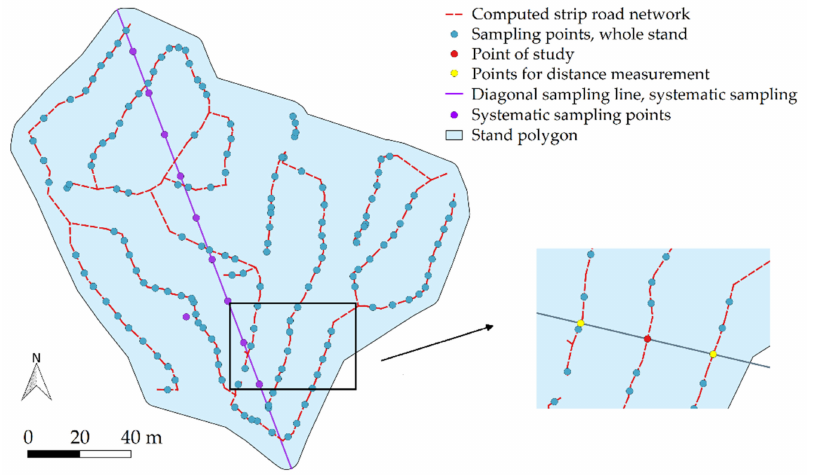
Figure 6. Example of sampling the stand for the calculation of strip road spacing. The sampling locations of the whole strip road network are shown with turquoise dots. In this sampling, the center point of the line segment under study is calculated (red dot). The perpendicular distances between two adjacent strip roads are also determined (yellow dots). The spacing value for the segment is the average of the two distances at both sides of the segment. For comparison, the purple diagonal line and dots indicate systematic sampling with ten points at most (see Section 2.4.2), which corresponds to the field measurement of harvesting